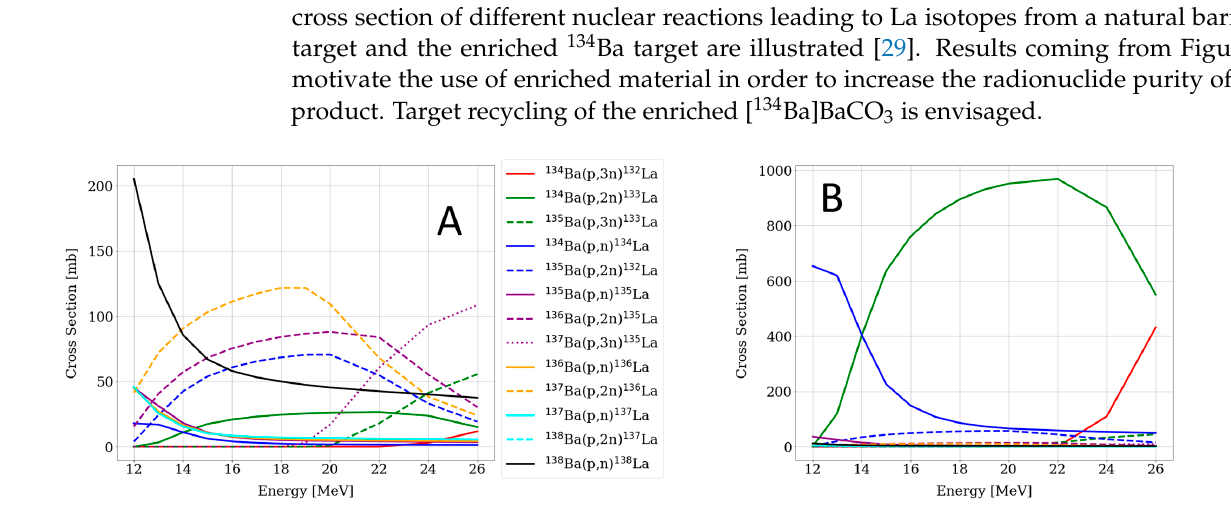
Figure 8. Cross section of nuclear reactions leading to La radioisotopes weighted for ( A ) natural BaCO 3 and ( B ) enriched [ 134 Ba]BaCO 3 target material. BaCO 3 and ( B ) enriched [ 134 Ba]BaCO 3 target